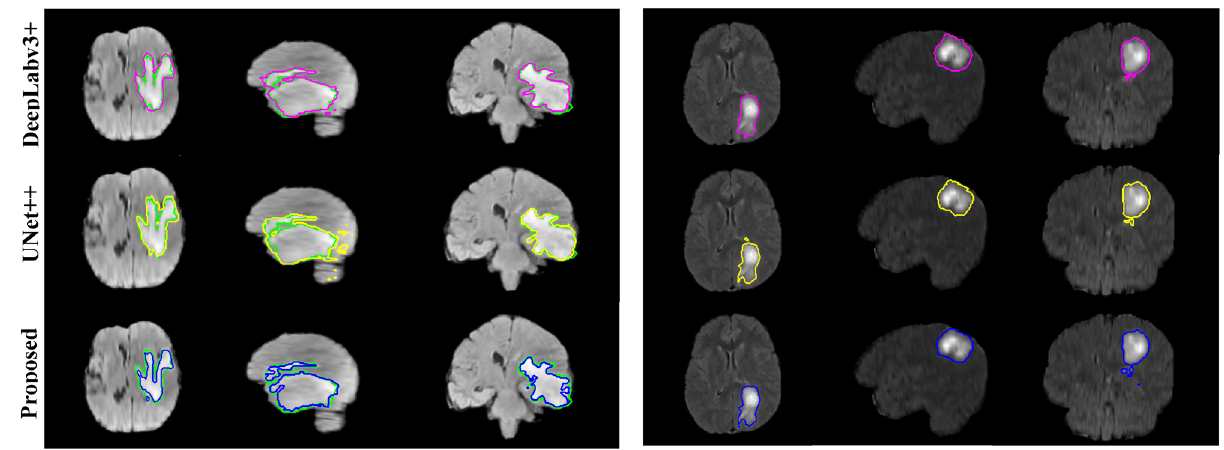
Figure 7. Examples of the segmented brain tumors. Left indicates some examples from the local test data, while right refers to examples from the actual validation data. The green, magenta, yellow, and blue contours refer to the ground-truth annotations and the segmented results via the DeepLabv3 + , UNet + + , and proposed CMM-Net, respectively. First to third columns of each sample represent the axial, sagittal, and coronal views, respectively.